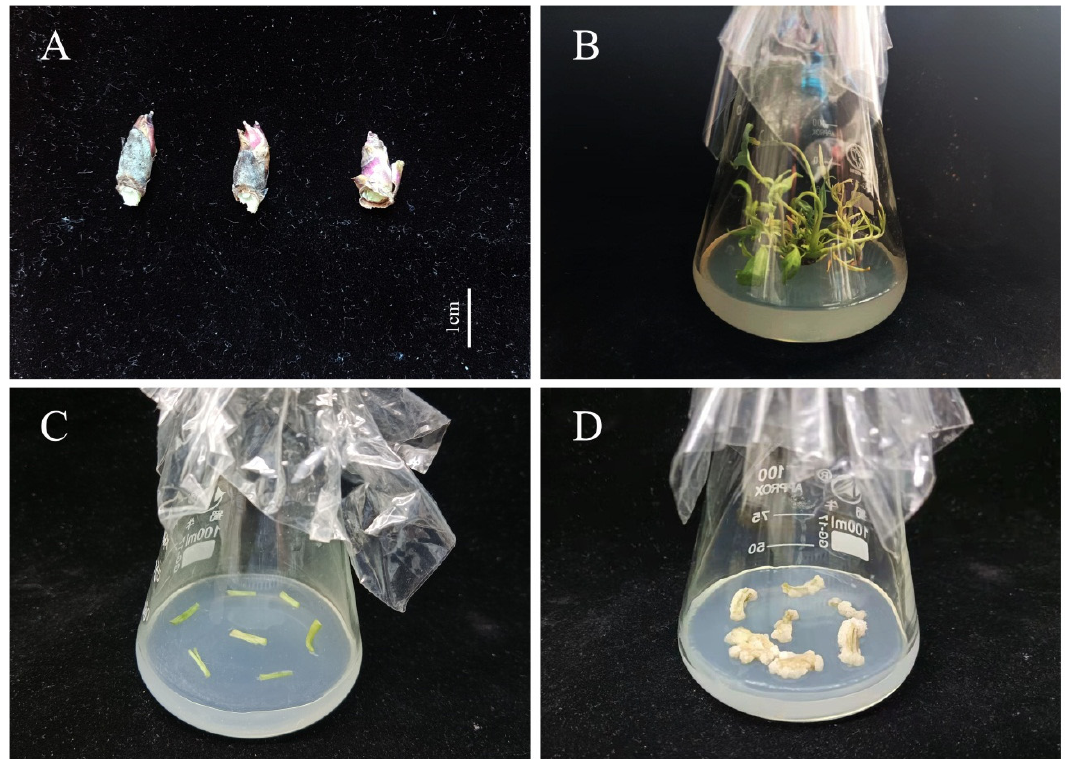
Figure 1. Induction of non-embryogenic callus in the tree peony (( A ), Axillary buds; ( B ), Plantlets in vitro; ( C ), Callus induction; ( D ), Non-embryonic callus). Scale bar: 1